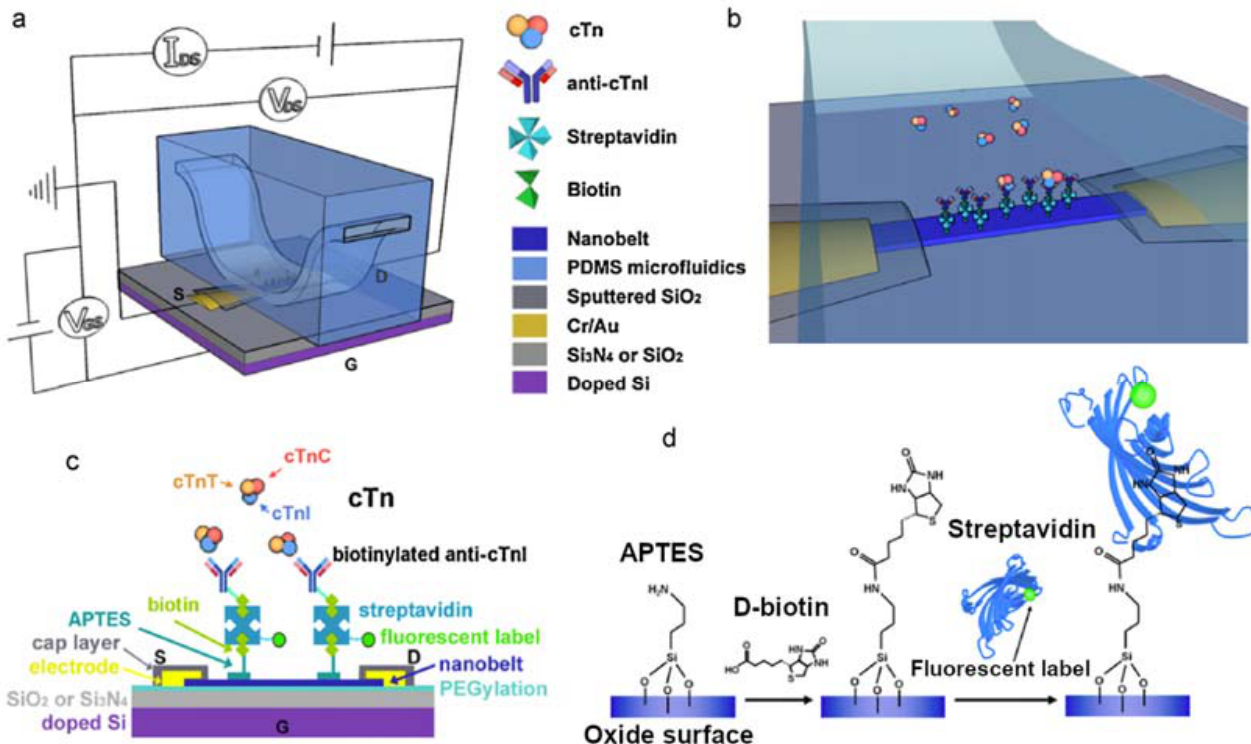
Figure 2. ( a ) Representation of the integrated chip and the electrical connections used in the study. S = source, D = drain, and G = gate. ( b ) Simplified model of cTnI binding in the microfluidic channel. ( c ) Detailed schematic of the detection system assembly. ( d ) Schematic diagram of the surface biotininization of the nanobelt of SnO 2 . Reprint by permission from Elsevier.